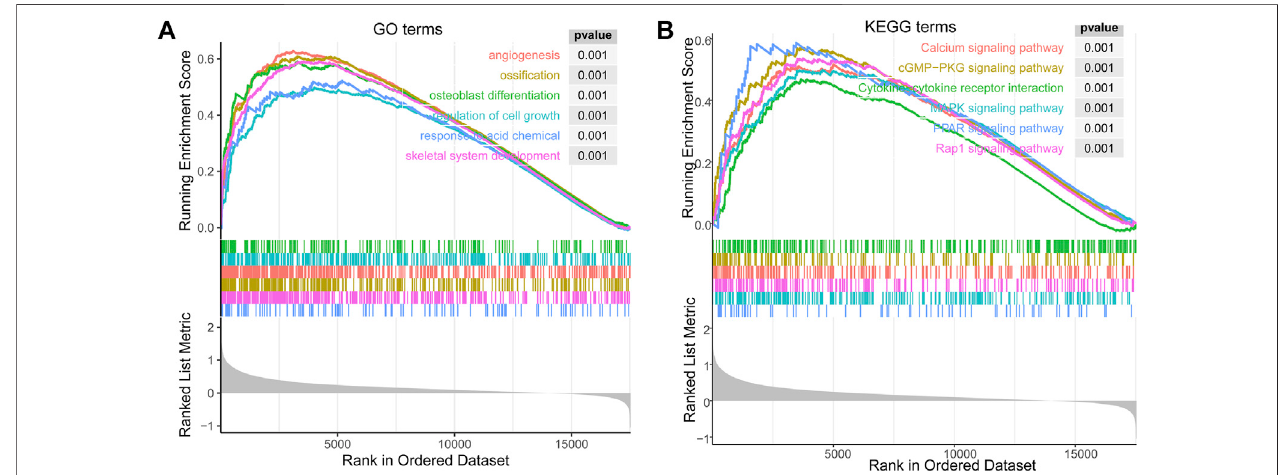
FIGURE 5 | The enrichment results of GSEA correlated with PLOD2 expression in STAD. (A) top 6 signi fi cant enrichment GO terms. (B) top 6 KEGG terms.